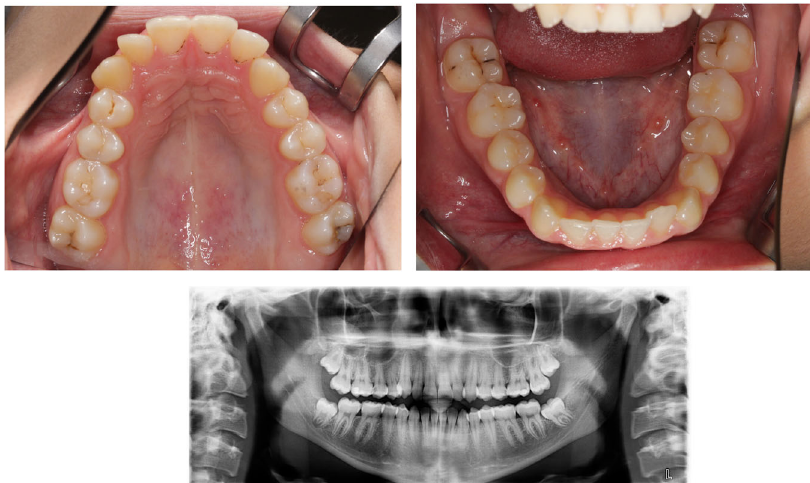
Fig. 1 Example of a presented case: female with no general diseases and medication and early loss of tooth #55 due to caries that was treated with a space maintainer. She underwent no further orthodontic treatment. Her follow-up dental visits were irregular. The tooth to be inspected was